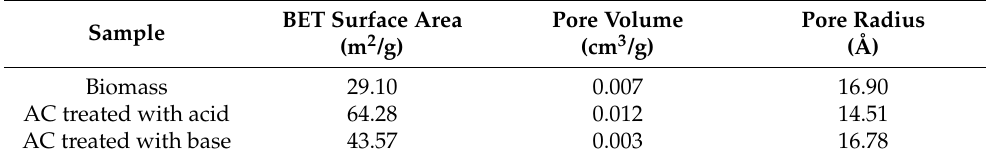
Table 1. BET analysis of biomass and AC treated with acid and base.